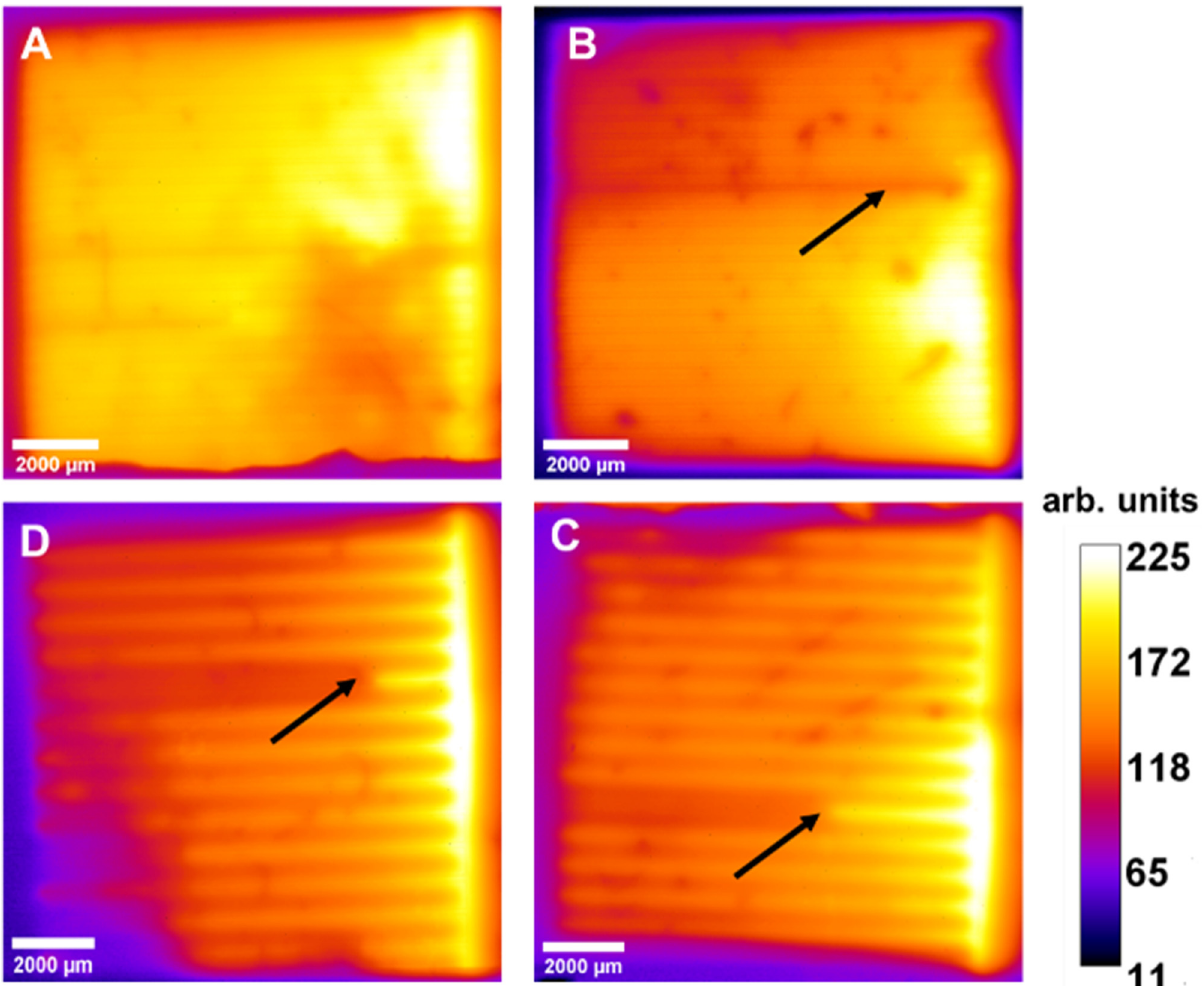
Fig. 8. EL image of four different 3T-bottom cells, labelled A, B, C, and D, under 1 V applied bias. EL intensity is two times greater in samples A and B than C and D due to the non-radiative recombination. Dark arrows indicate a lousy adherence of fi